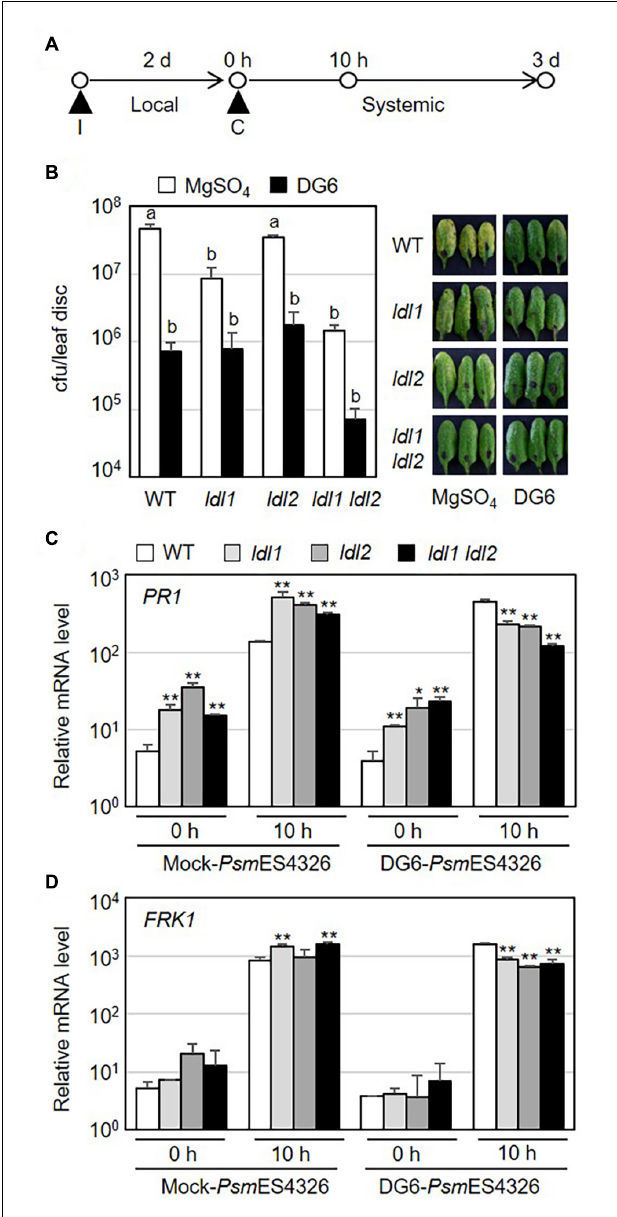
FIGURE 4 | Systemic resistance is not further enhanced in ldl1 ldl2 double mutants. (A) Schematic diagram of the timepoints for pre-immunization (I) with avirulent strain Psm ES4326/ AvrRpt2 (DG6) (OD 600 = 0.01) or 10 mM MgSO 4 (mock), the second challenge inoculation (C) with virulent Psm ES4326 (OD 600 = 0.0001 or 0.01), and tissue samplings to evaluate the expression of defense-related genes and bacterial growth. (B) The growth of virulent Psm ES4326 in distal leaves of plants treated with 10 mM MgSO 4 or avirulent Psm ES4326/ AvrRpt2 (DG6). Bars indicate SEM ( n = 8). Different letters indicate significant differences ( p < 0.05, one-way ANOVA-Tukey test). Photographs of infected leaves were taken at 3 days post-challenge inoculation. The experiments were repeated at least three times with similar results. (C,D) Transcript levels of PR1 and FRK1 in distal leaves of immunized plants before (0 h) and after challenge inoculation (10 h) with Psm ES4326 (OD 600 = 0.01). Bar indicates the SD (* p < 0.05, ** p < 0.01, two-way Student’s t -test, n = 3). The experiments were repeated twice with similar results ( Supplementary Figure 4